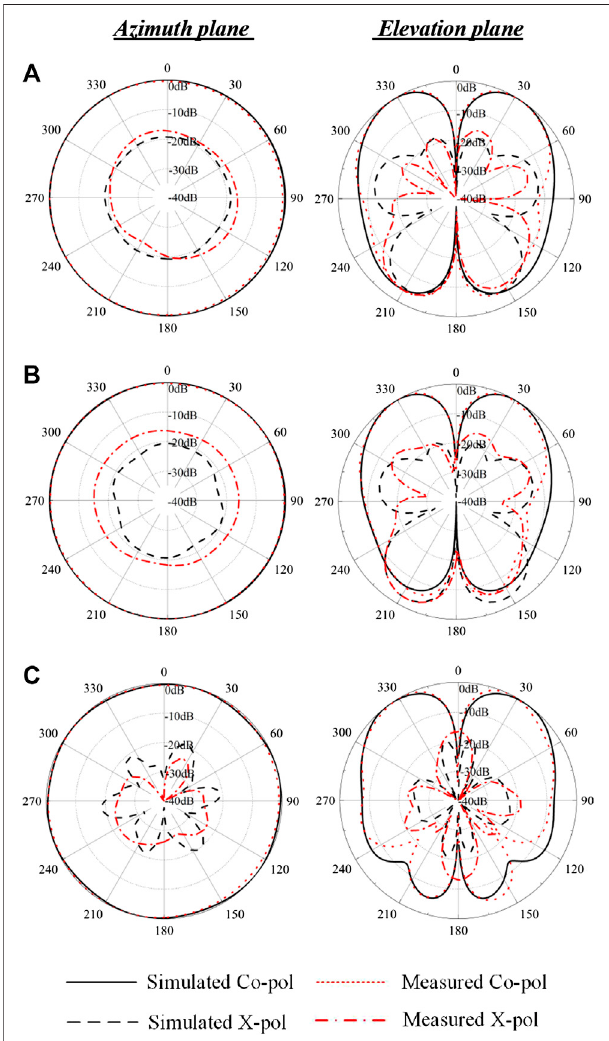
FIGURE 6 | Simulated and measured radiation patterns: (A) 2.35 GHz; (B) 2.55 GHz; (C) 5.9